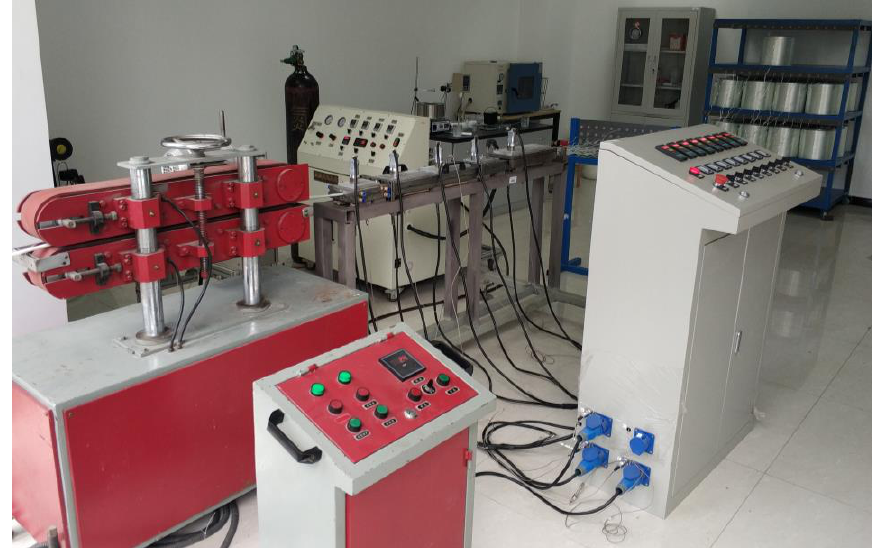
Figure 3. The developed thermoplastic reaction injection pultrusion test line.